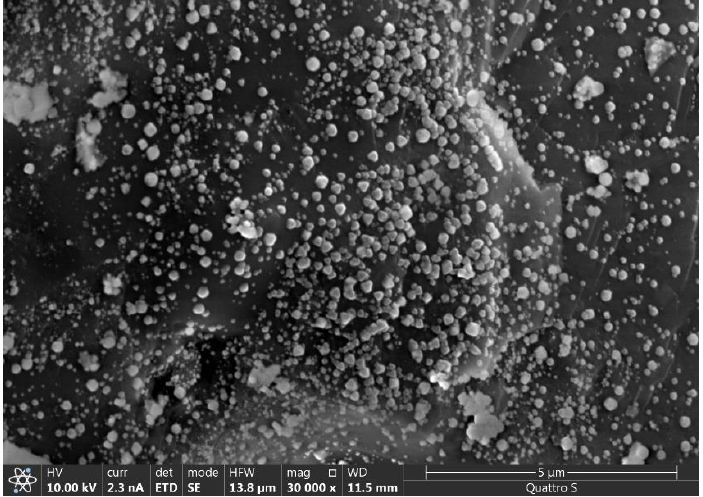
Figure 8. SEM image of ex situ prepared catalyst ’ s surface with nickel oxide particles (light color).